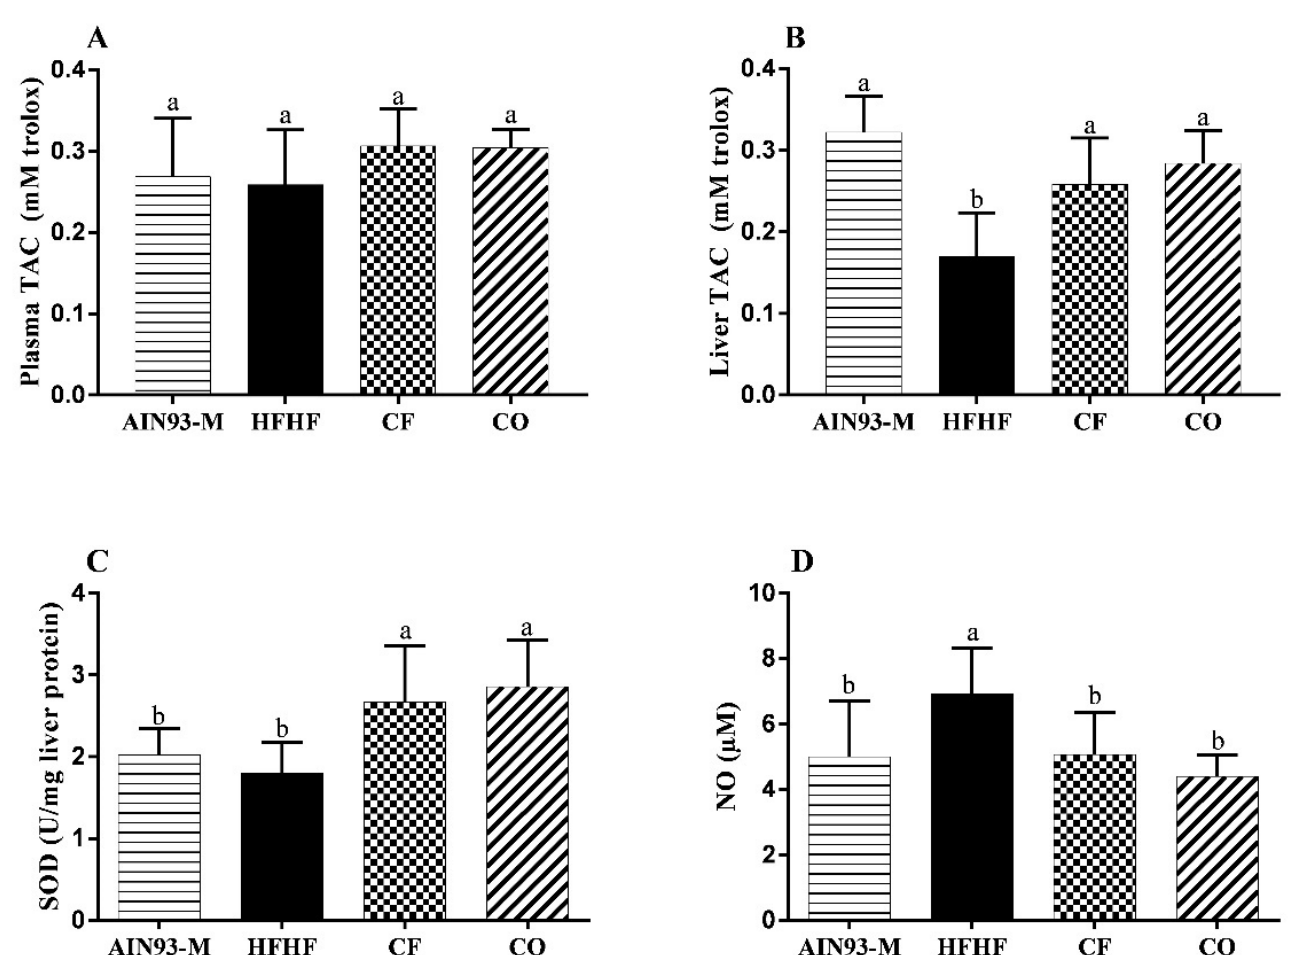
Figure 6. Effect of diets on oxidative stress. ( A ) plasma total antioxidant capacity (TAC); ( B ) liver total antioxidant capacity (TAC); ( C ) superoxide dismutase (SOD); and ( D ) nitric oxide (NO) in the liver. The animals were fed diets: AIN93-M: standard rodent diet; HFHF: high-fat and high-fructose; chia flour (CF): HFHF with 4% of soybean oil replaced by chia flour lipid (14.7% of chia flour); and chia oil (CO): HFHF diet with 4% of soybean oil replaced by 4% of chia oil for 10 weeks. Values are represented by average and standard deviation ( n = 10). The difference between the averages was analyzed by the one-way ANOVA test followed by the Newman–Keuls post-hoc test. Different letters indicate significant statistic difference ( p < 0.05).